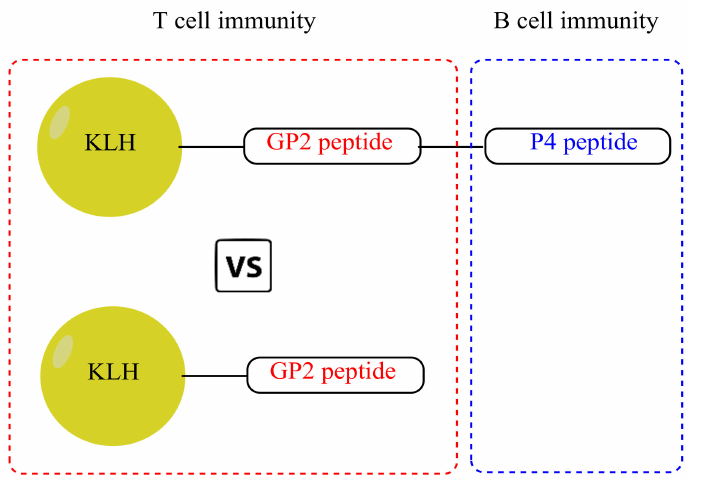
Figure 1. Schematic structure of the HER2/neu-based multi-epitope peptide vaccine